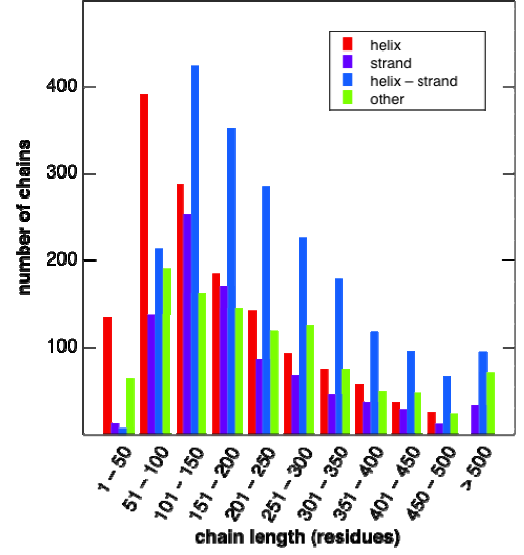
Figure 1. Protein length distributions. The number of protein chains of different lengths in the motif set, classified by secondary structure content, as described in Section